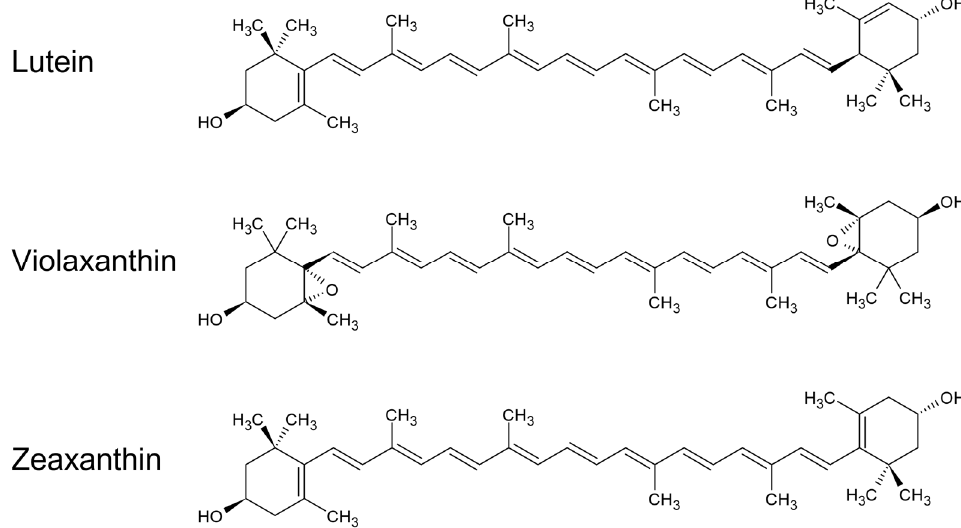
Figure 6. Molecular structure of lutein, violaxanthin, and zeaxanthin: In the lut2 mutant, violaxanthin replaces lutein, whereas in the lut2 npq2 mutant all xanthophylls are replaced constitutively by zeaxanthin.